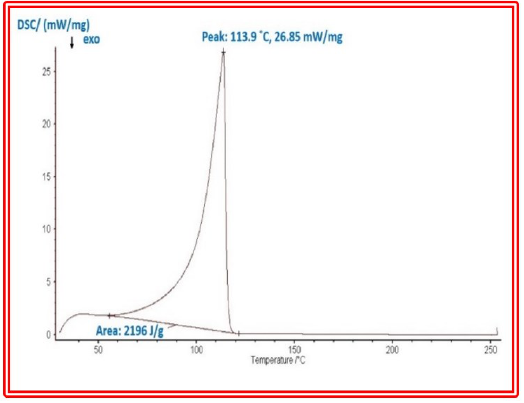
Figure 6. DSC profile of chickpea peptide.